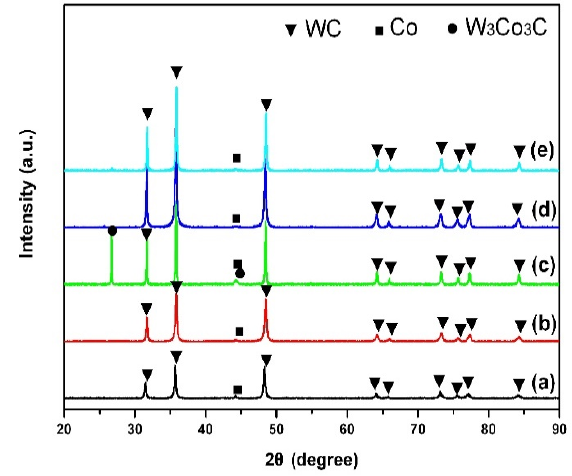
Figure 1. XRD patterns of the composite powders and the specimens sintered at different temperatures for 40 min: ( a ) composite powders; ( b ) 1100 °C; ( c ) 1200 °C; ( d ) 1300 °C; ( e ) 1400 °C.